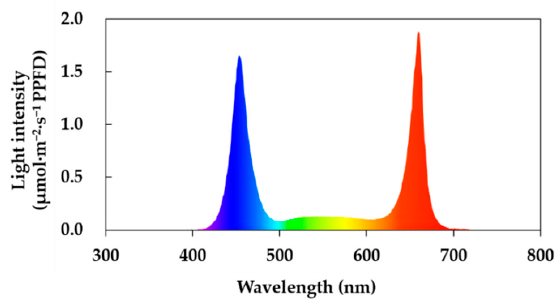
Figure 1. The spectrum of the supplementary light source (mixed LEDs: W 1 R 2 B 1 ) used in the experiment: W, cold white LED (peak wavelength at 452 and 561 nm); R, red LED (peak wavelength at 659 nm); and B, blue LED (peak wavelength at 452 nm).The spectral distributions were measured with a portable spectroradiometer (Spectra Light ILT 950, International Light Technologies, Inc., Peabody, MA, USA).